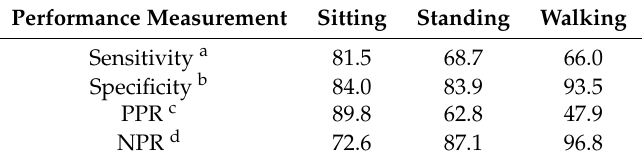
Table 7. Free living: performance of the VitaBit with ActiGraph as criterion measurement. Performance Measurement Sitting Standing Walking Sensitivity a